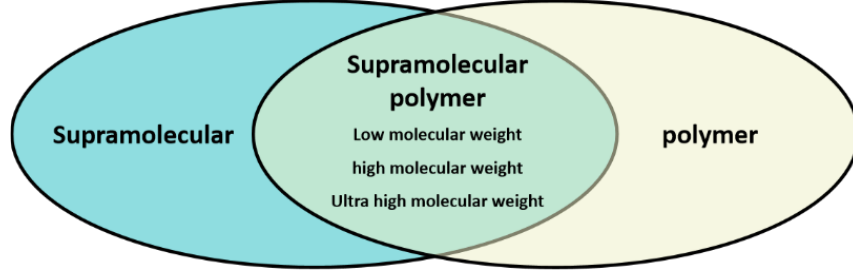
Figure 1. Category of supramolecular polymers.